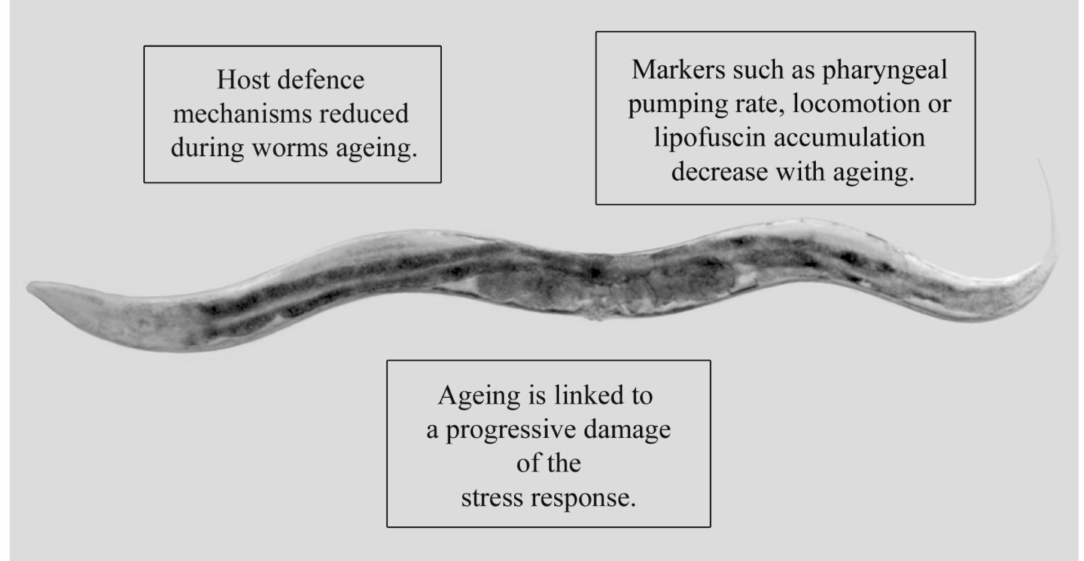
Figure 1. Micrograph representing the model organism Caenorhabditis elegans (the head is on the left; the tail is on the right). The principal biomarkers and physiological traits associated with ageing are described in the squares. Magnification: 5 ×